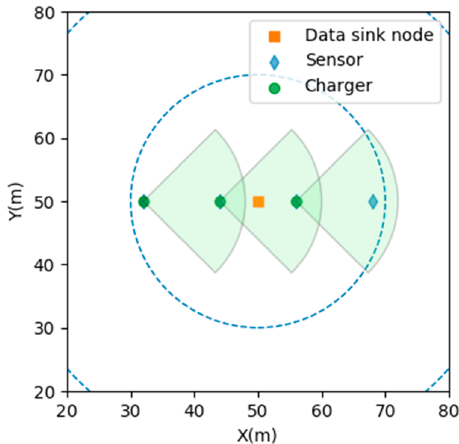
Figure 5. The position of this charger is redundant.